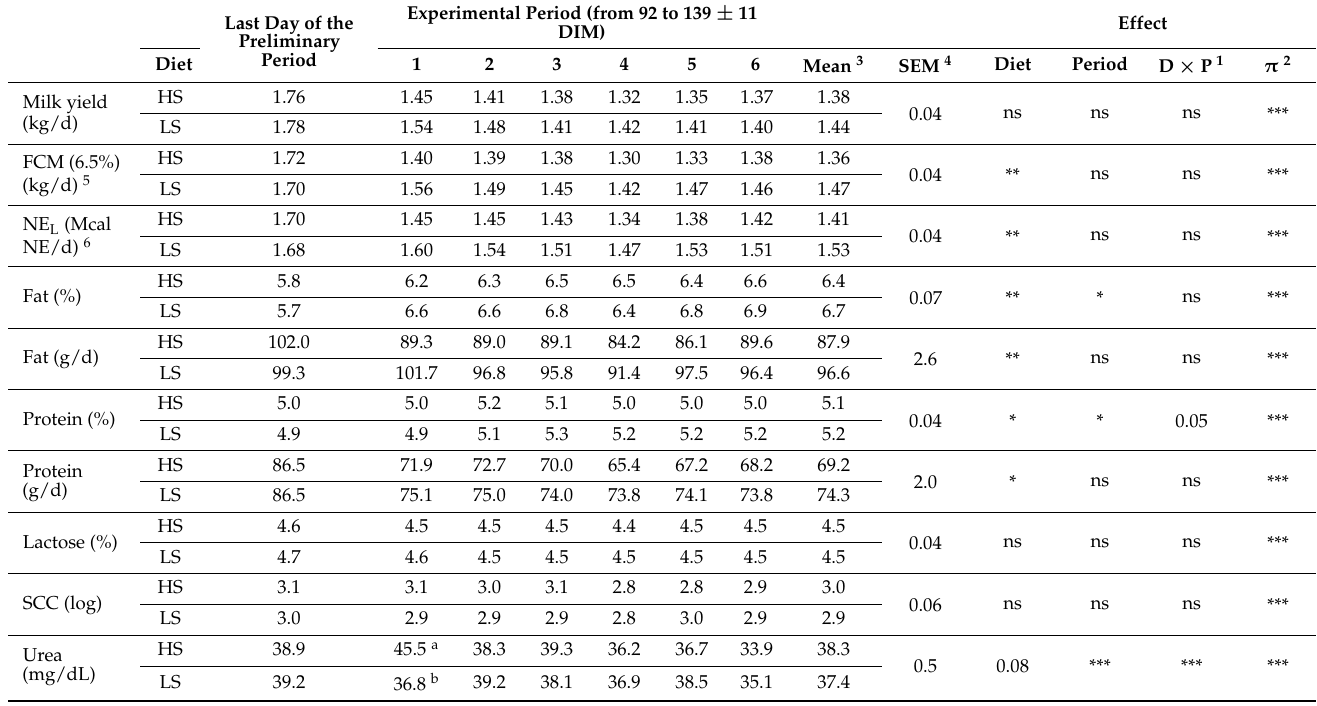
Table 4. Evolution of milk yield, fat-corrected milk yield, net energy for lactation, fat, protein, lactose, somatic cell count and urea in mid-lactating Sarda ewes fed high-starch and low-starch diets. Experimental Period (from 92 to 139 ± 11 Last Day of the DIM) Preliminary Period